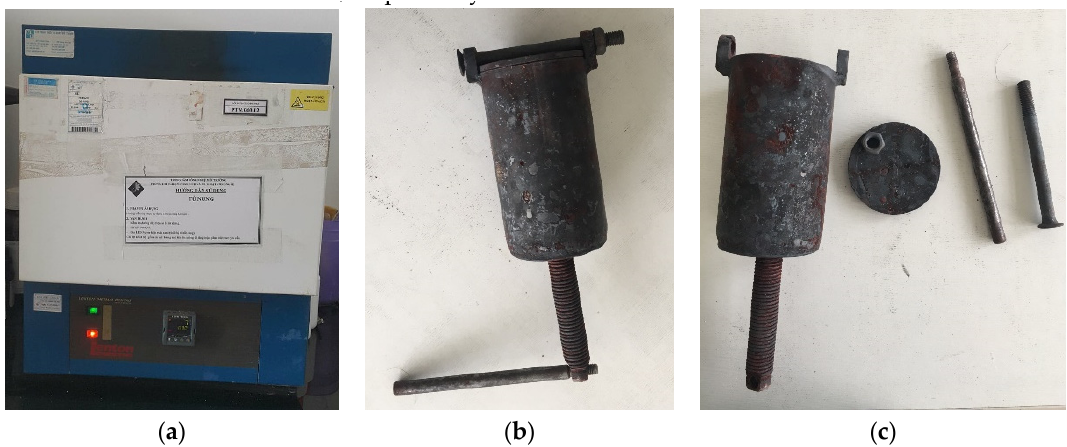
Figure 2. ( a ) Lab-scale closed furnace (EF 11/8B, Lenton, Hope Valley, UK) for biochar production; ( b ) closed-steel cylinder for containing biomass; ( c ) components of the closed-steel